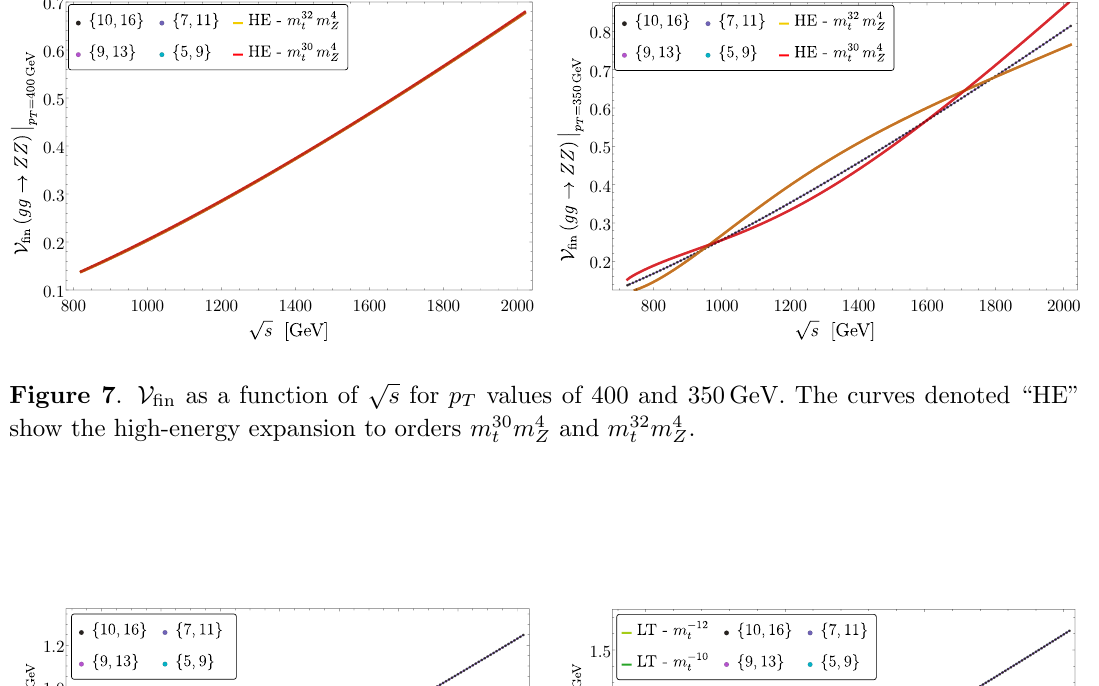
m 4 and m 32 m 4 . t t Z Z